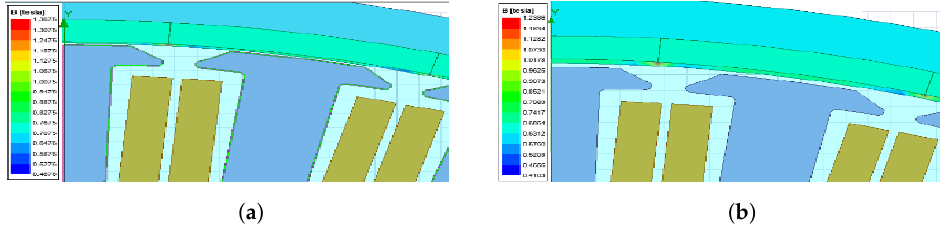
Figure 8. Magnetic flux density for air gap lengths of ( a ) 0.5 mm, ( b ) 1mm, ( c ) 1.5 mm, and ( d ) 2